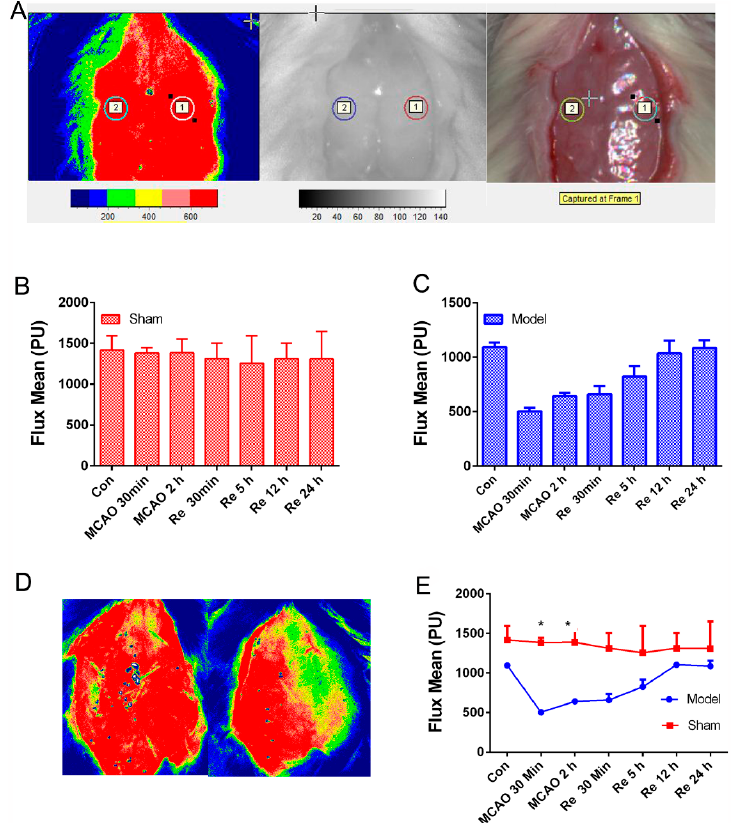
Figure 2. Cerebral blood flow assessed by the laser Doppler blood flow assessment in rats with a middle cerebral artery occlusion / reperfusion MCAO / R